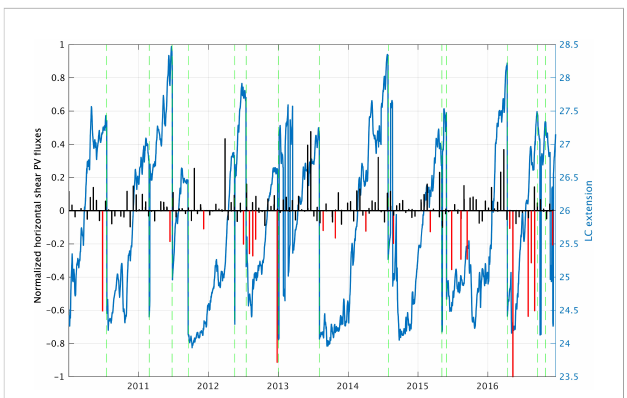
FIGURE 5 Normalized horizontal shear PV fl uxes (black and red bars) of coherent boundaries detected south of the Yucatan Channel and propagated into the GoM, along with the LC northernmost extension (blue line). The red bars indicate values <=-0.1. The dashed green lines mark the LCE detachments/ fi nal